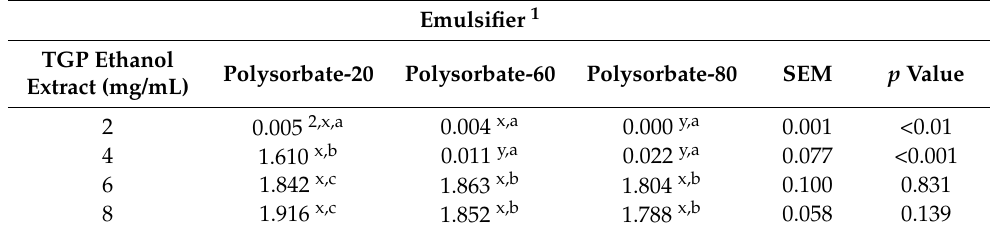
Table 3. Effects of TGP ethanol extract concentrations on the emulsification efficiency of TGP.